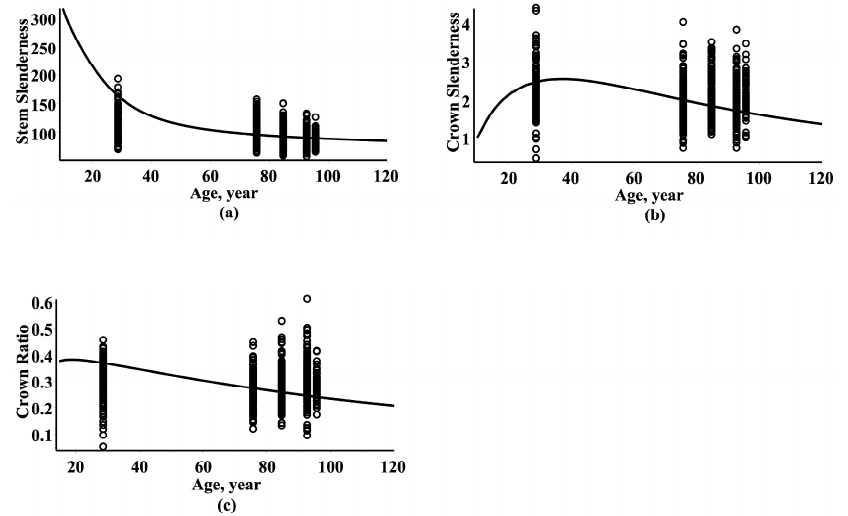
Figure 4. Coefficients of slenderness: ( a ) Slenderness of stem with observed dataset; ( b ) Slenderness of crown with observed dataset; ( c ) Competition index with observed dataset.